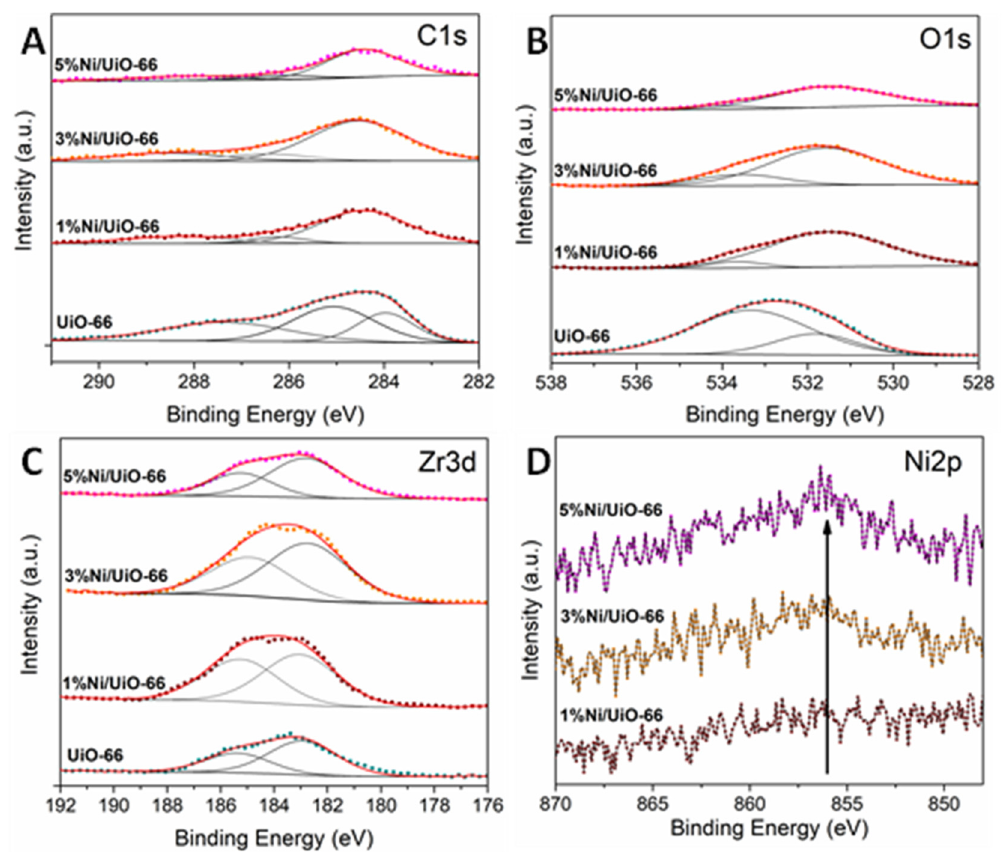
Figure 3. XPS spectra of the prepared samples in the ( A ) C1s, ( B ) O1s, ( C ) Zr3d and ( D ) Ni2p regions.